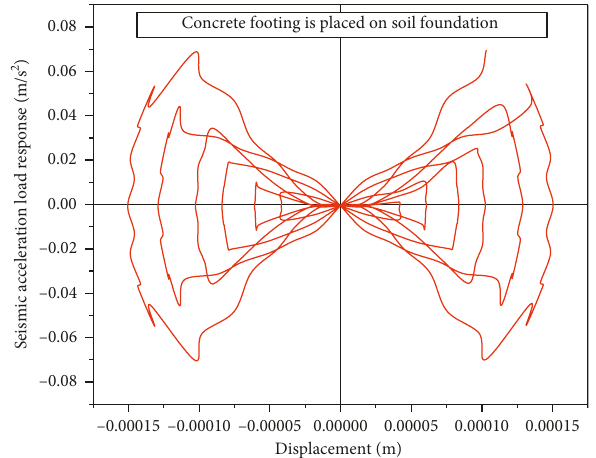
Figure 7: Seismic acceleration load response vs displacement at the base of a concrete footing, during concrete footing-soil foundation interaction.